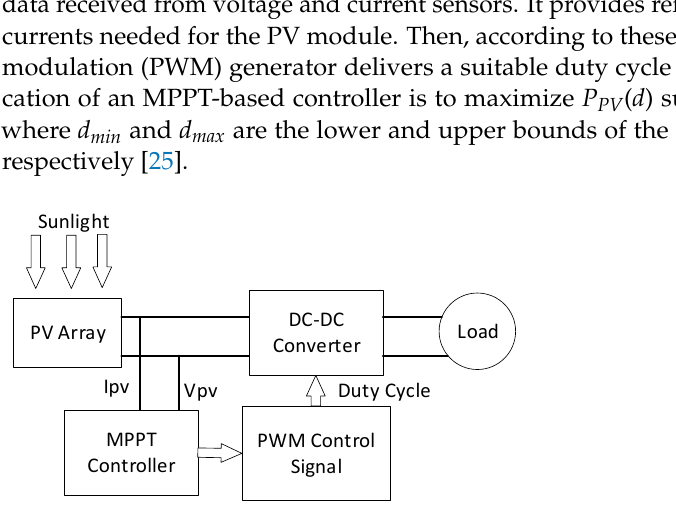
Figure 3. Centralized or field MPPT architecture (Source: Authors; architecture adapted from [26]).